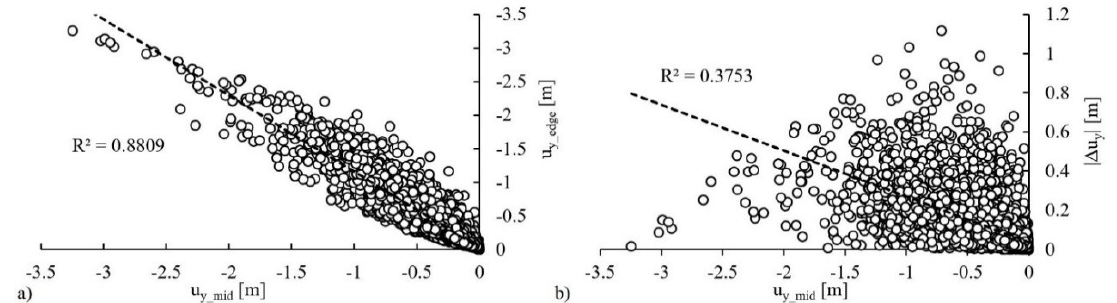
Figure 11. Correlation of u y_mid to ( a ) vertical displacements at crest edges and ( b ) absolute differences between edge and middle crest points. Appl. Sci. 2020 , 10 , x FOR PEER REVIEW